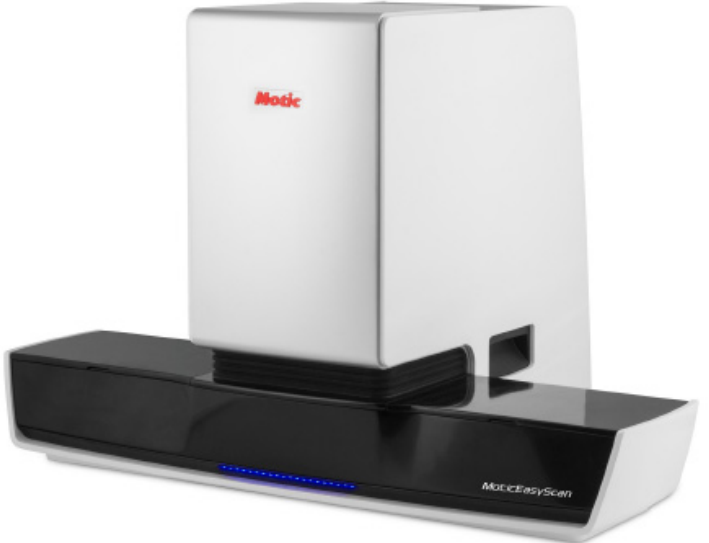
Figure 3. Microscopical scanner EasyScan-AI from Motic for automated scanning of 10